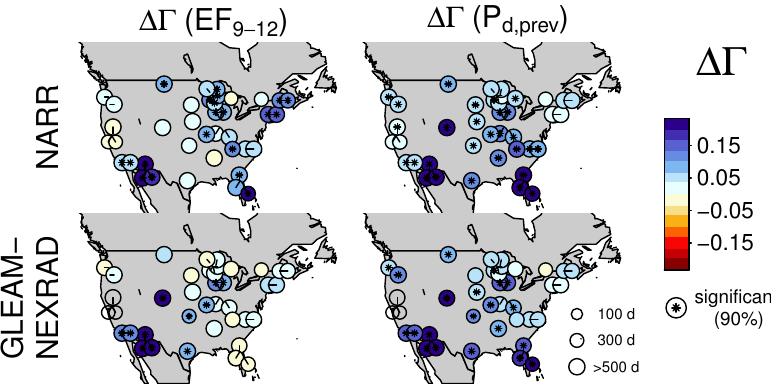
Figure 7. Difference in the probability of afternoon rainfall on days with high vs. low X , 10(X) , where X is the before-noon EF (left panels) or previous-day precipitation (right panels), for NARR (top row) and GLEAM–NEXRAD (bottom row). High (low) X refers to values higher (lower) than the 60th (40th) percentile of X , i.e., 10(X) = 0(r | X > X Q60 ) − 0(r | X ≤ X Q40 ) . Values significantly different from 0 at the 90% level are indicated by a black asterisk. The size of the dots indicates the number of days included in the computation according to the legend shown on the bottom right map. Empty dots indicate sites with unreliable NEXRAD data.